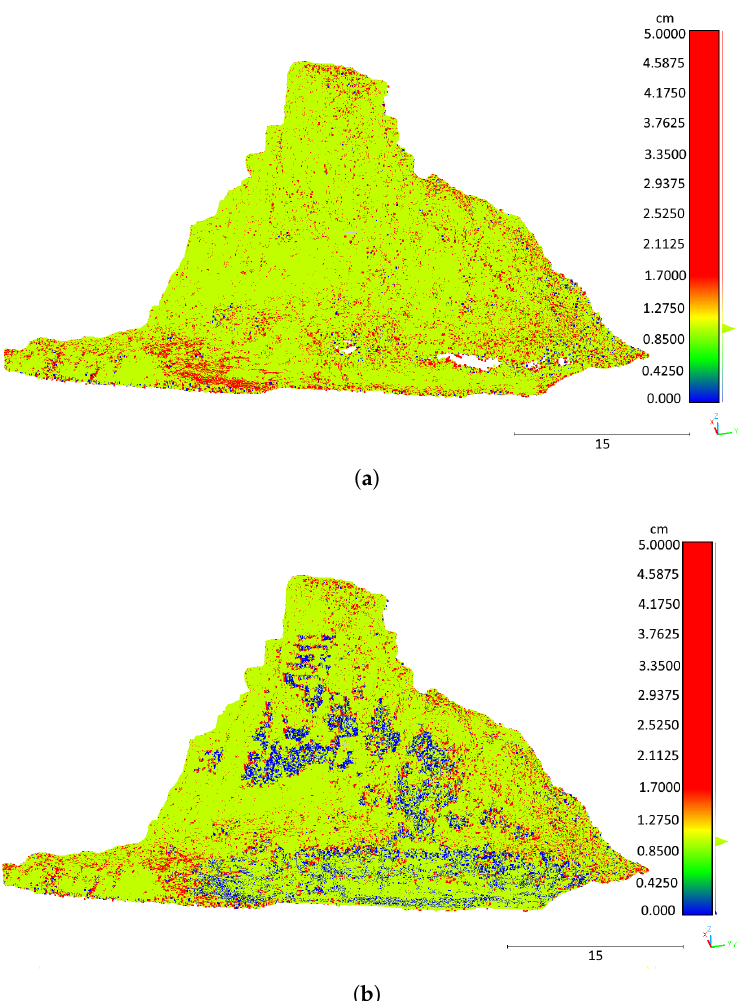
Figure 9. Dense point clouds colored by mean neighborhood distances from kd-tree algorithm computation. Subfigure ( a ) represents the point cloud from the UAV alone whilst ( b ) shows the joined UAV/SPI point cloud using the proposed